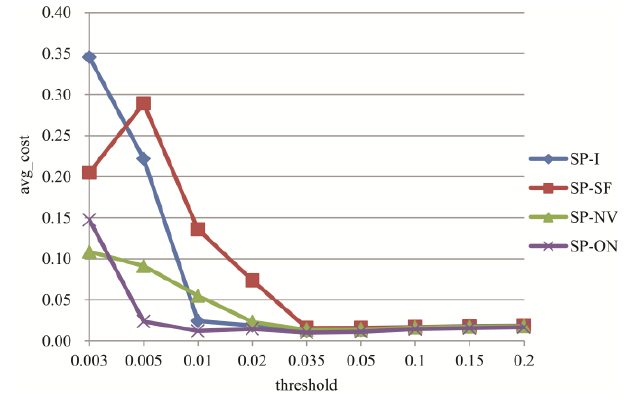
Figure 4. Average cost of microblog clustering for different similarity thresholds.